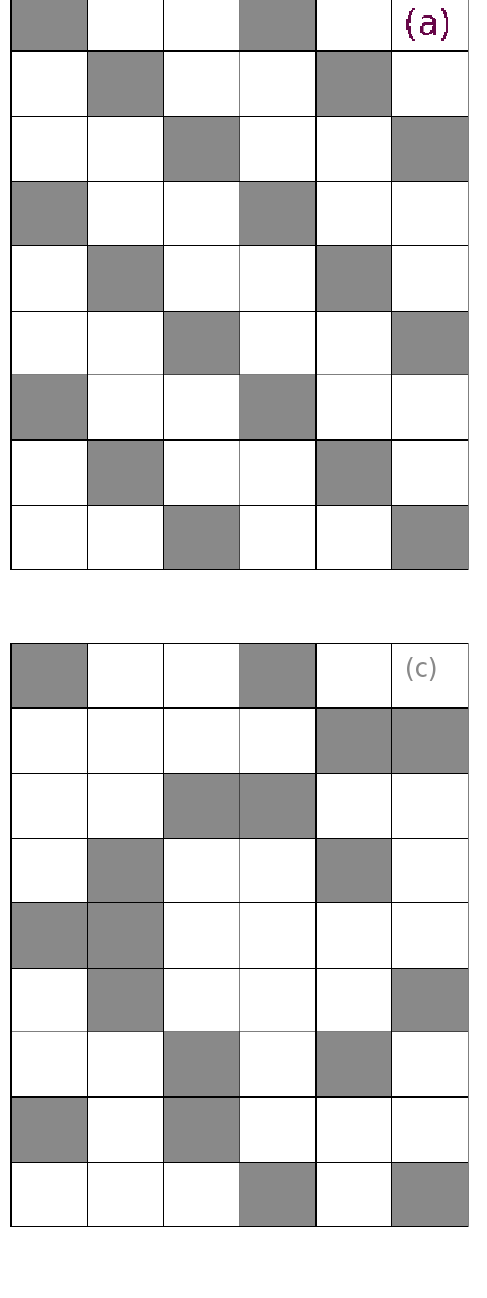
= 3 and MT r = 2 for all i and j respectively. Case i j